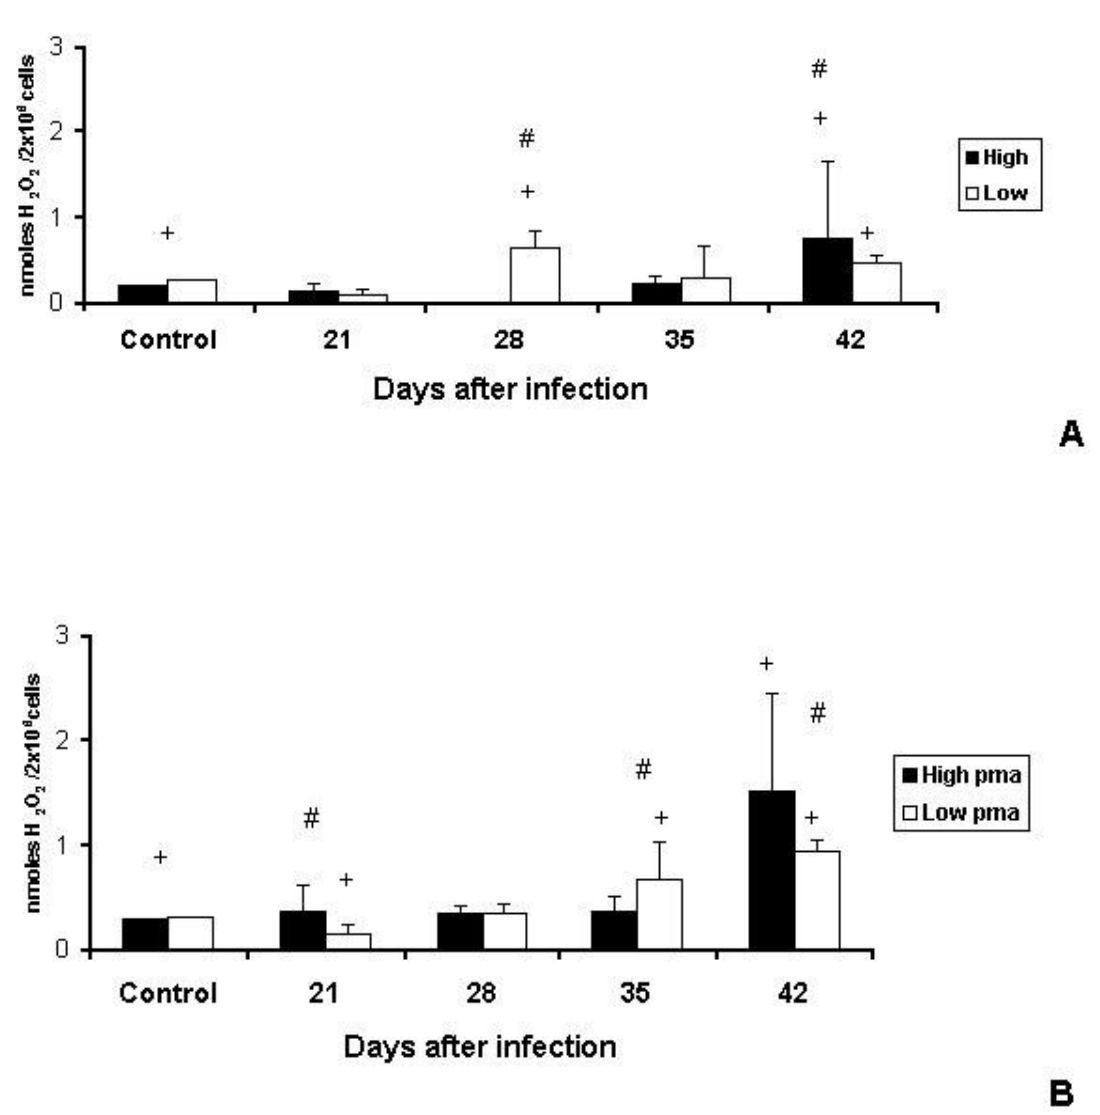
Figure 3. Production of H of High and Low antibody producer (Selection IV-A) mice infected with Mycobacterium bovis -AN controls. (A) Endogenous production of H Low mice. (B) Endogenous production of H Low mice subjected to additional phorbol myristate acetate (pma) stimulus . #: interline difference +: difference between infected animals and their respective